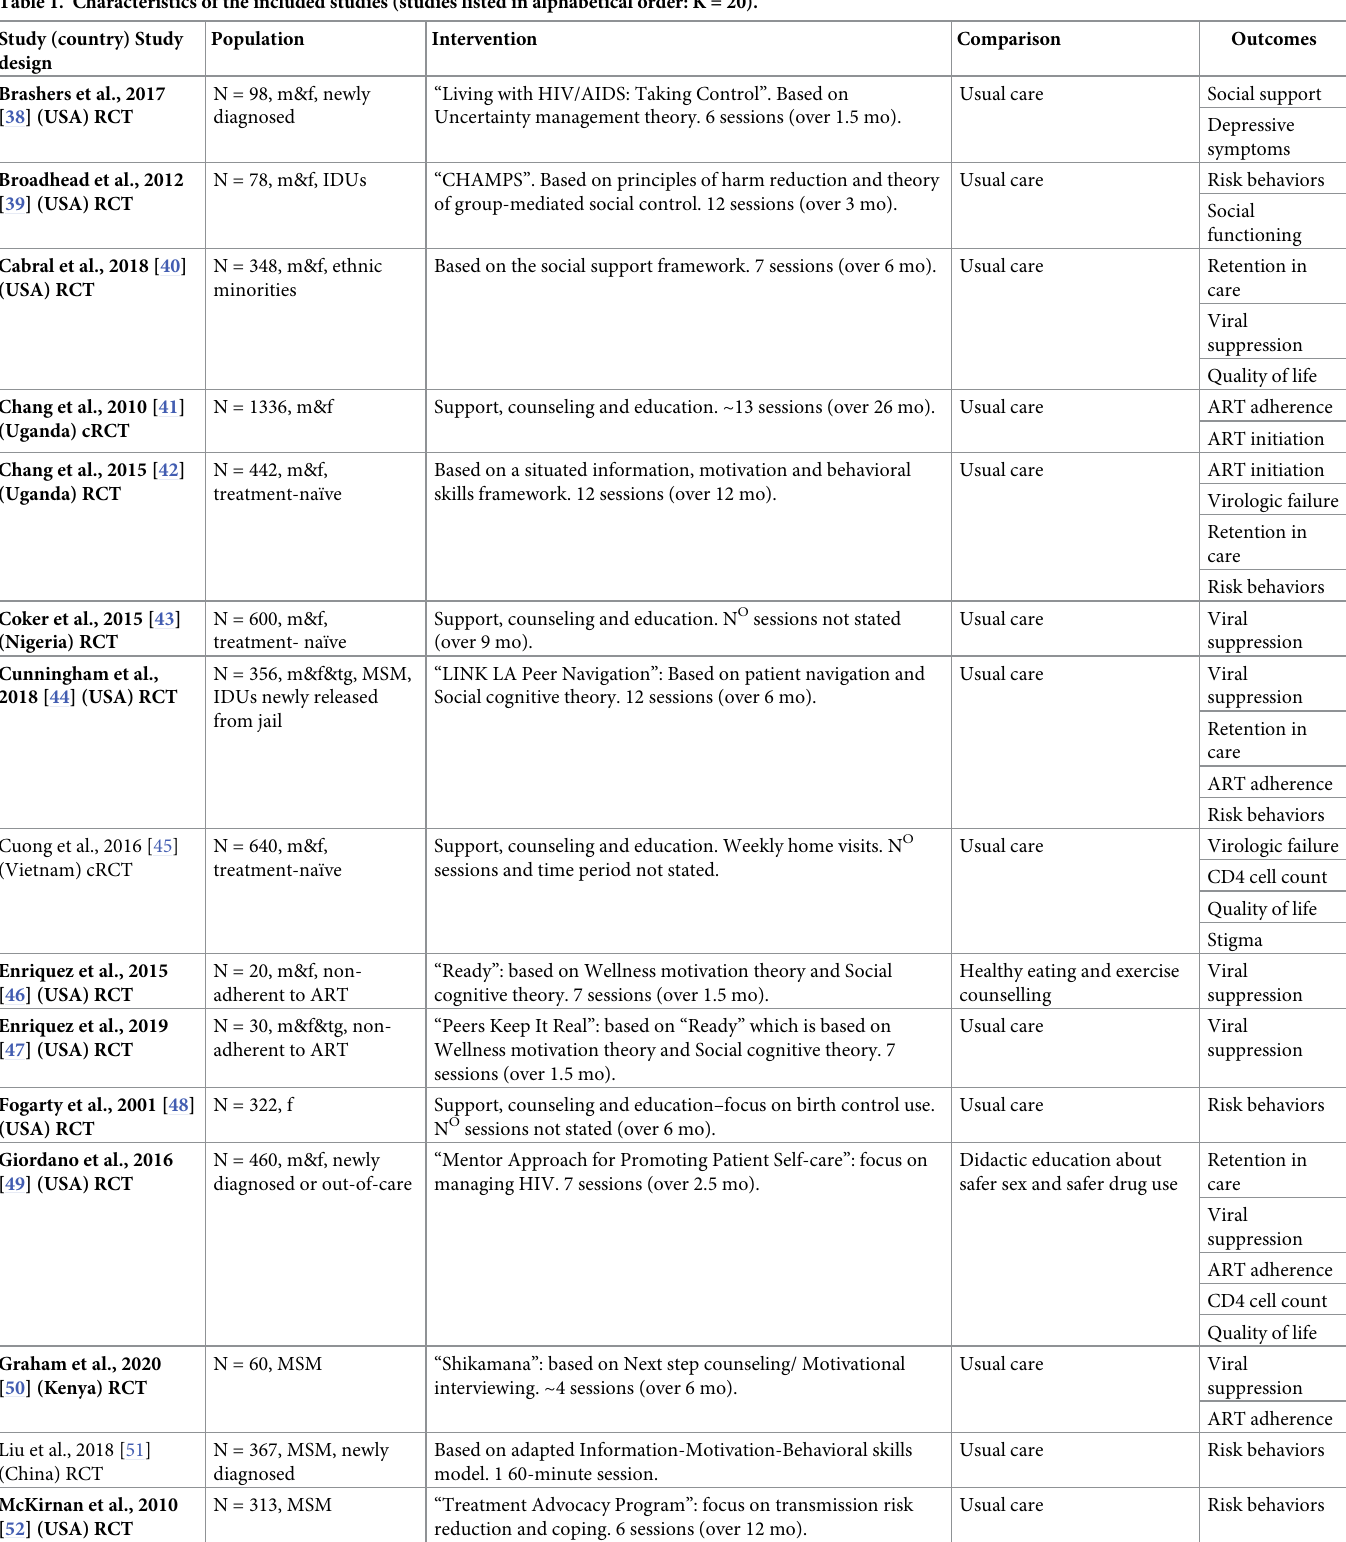
Table 1. Characteristics of the included studies (studies listed in alphabetical order: K =